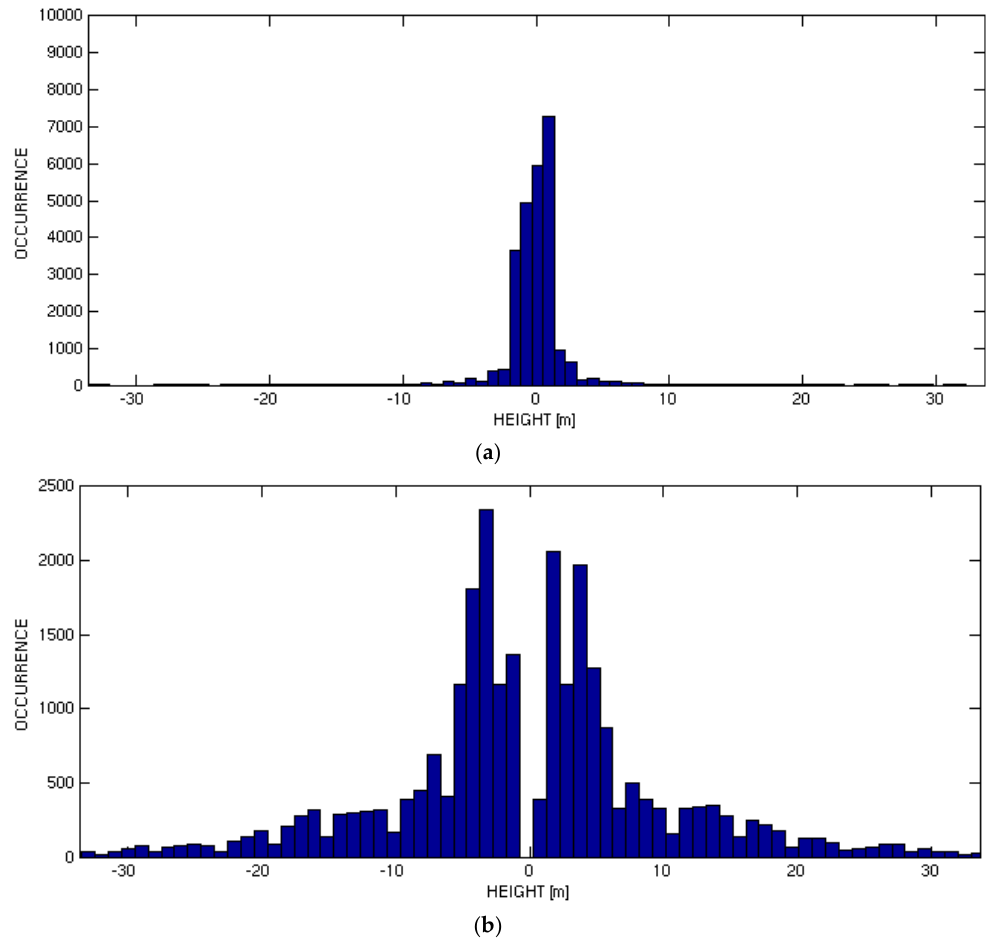
Figure 8. Histograms of the differences on a common grid of pixels between the residual topography 8 (height) associated with the single scatterers single-look and the closest ( a ) and farthest ( b ) double scatterer resulting from the multi-look